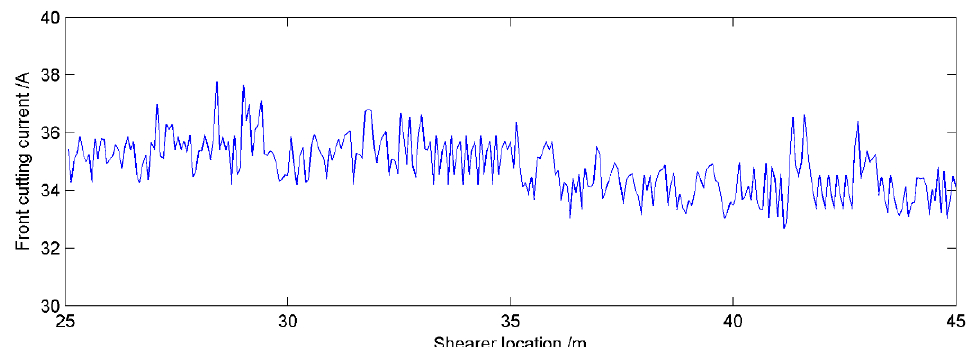
Figure 13. Front cutting current curve according to proposed method.